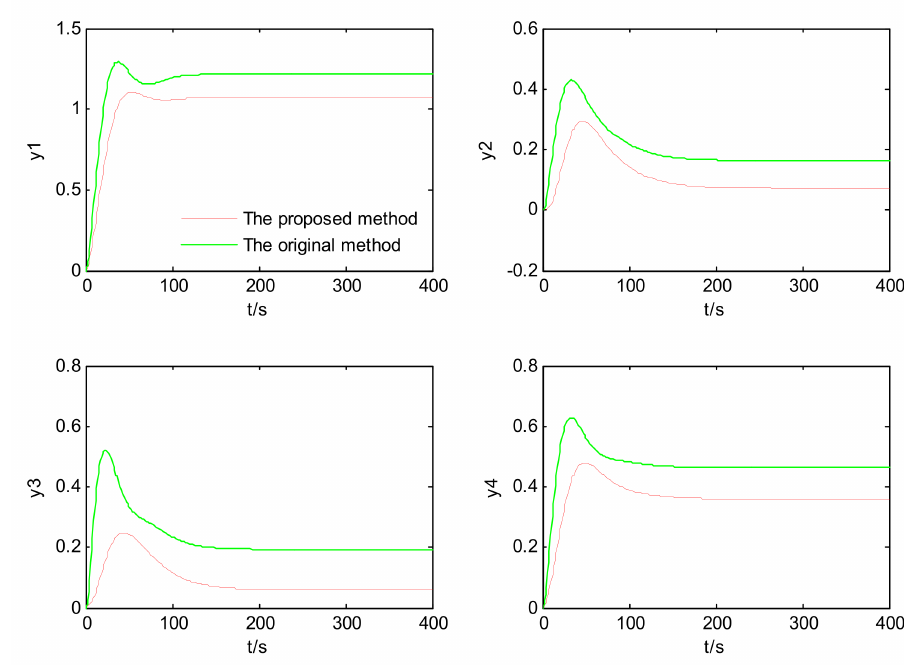
Figure 4. Set-point responses of r 1 = 1 and r 2 = r 3 = r 4 =